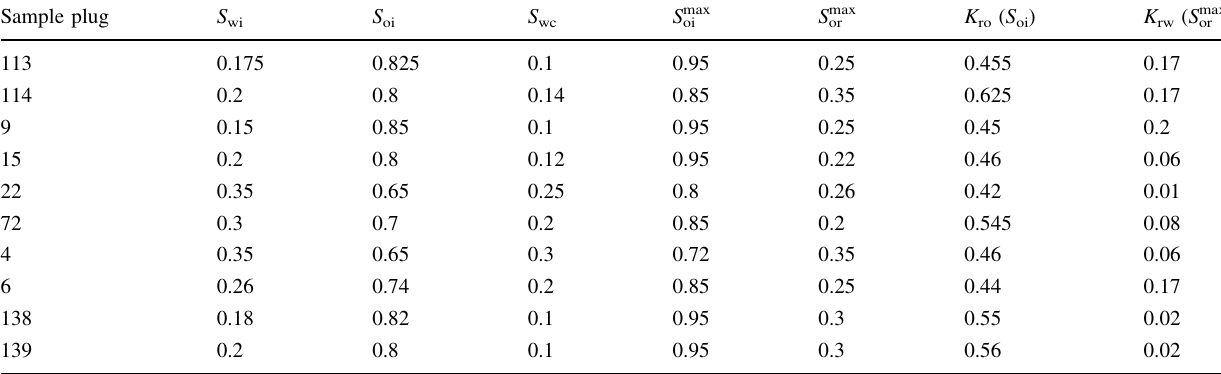
Table 5 End point parameters of permeability and saturation for sample plugs Sample plug